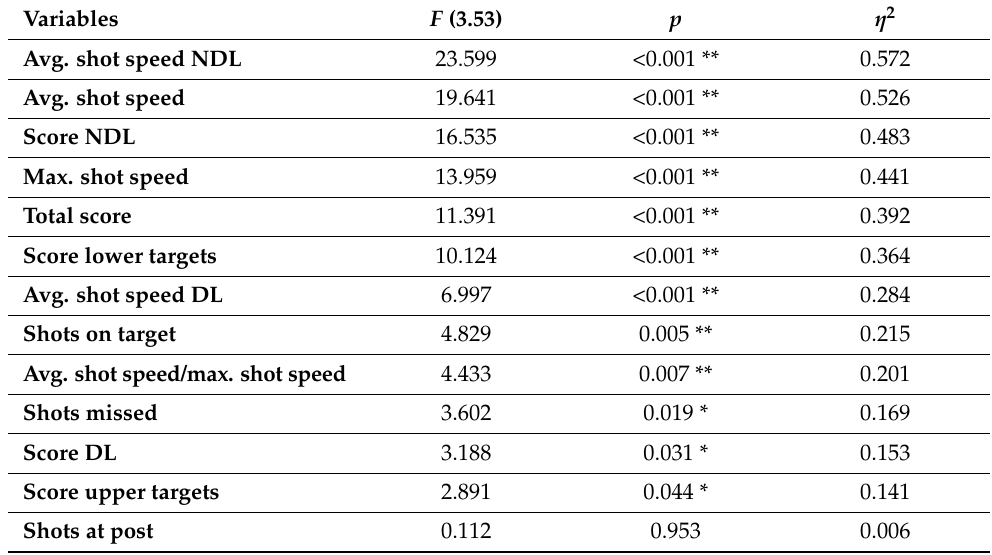
Table 2. Results of ANOVA.